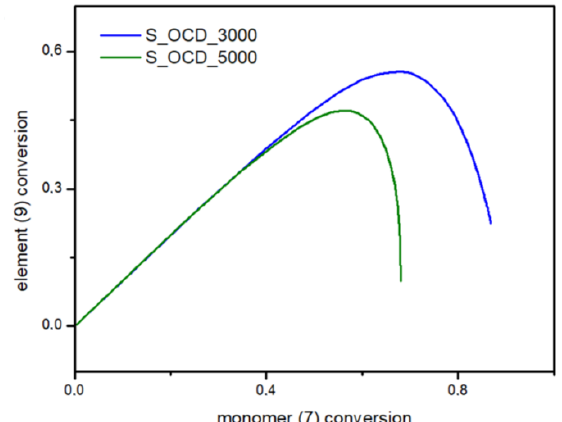
Figure 15. Conversion of ending groups of growing polymer chain (9) as a function of the 1,10- decanediol (7) conversion.